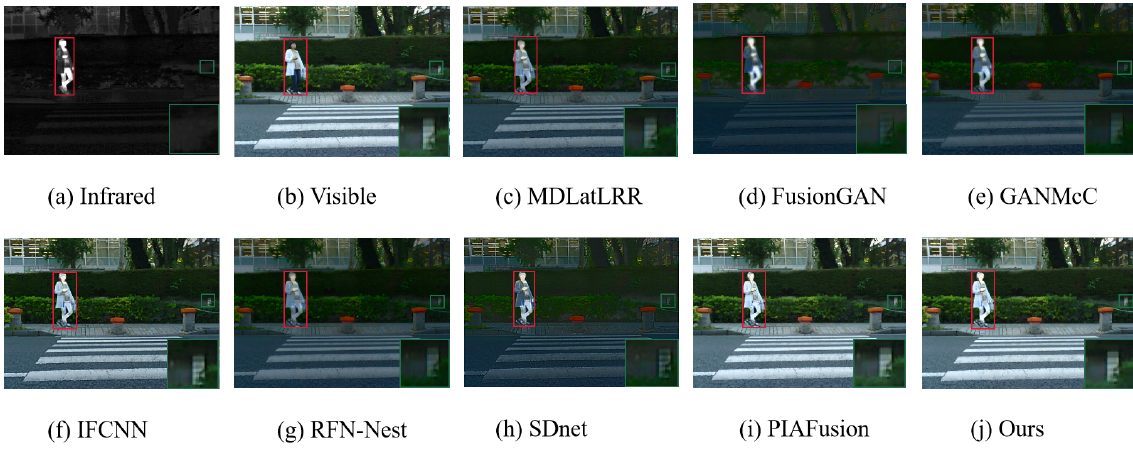
Figure 4. Comparative experiment for different fusion network of a typical daytime sample from the MSRS dataset.